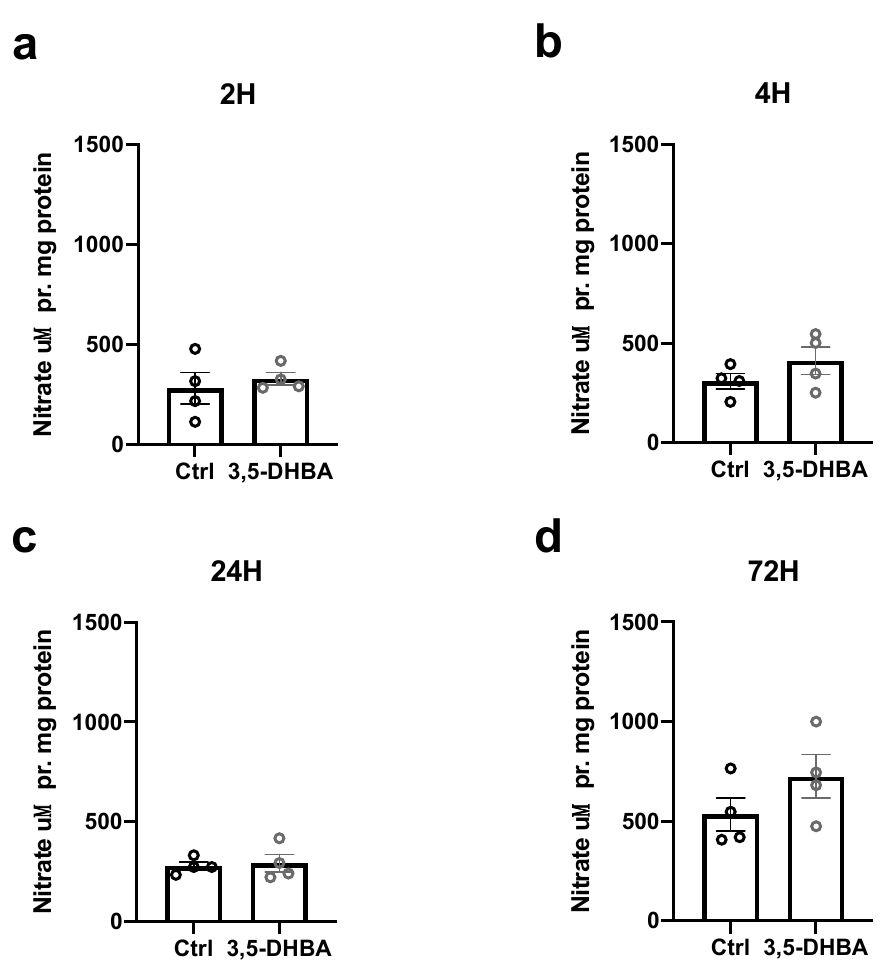
Figure 7. Nitric oxide concentration ( µ M) in response to 3,5-DHBA treatment. ( a – d ) Retinal explants were incubated for 2, 4, 24, and 72 h with 5 mM of 3,5-DHBA. No significant changes in extra retinal nitric oxide concentrations were found. Values are normalized to mg of protein in each sample. Values are presented as mean ± S.E.M ( n = 4 retinal quarters originating from four different whole retinas). Statistics: Unpaired t -test.